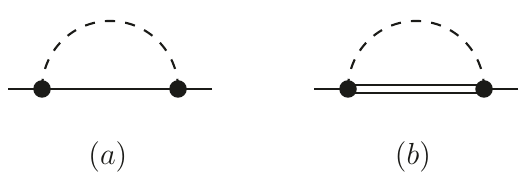
Figure 4 . Leading one-loop Feynman diagrams contributing the nucleon mass in baryon ChPT with pions, nucleons and deltas as explicit degrees of freedom. The solid, dashed and double lines represent nucleons, pions and deltas, in order. The black dots denote vertices of O ( p 1 )